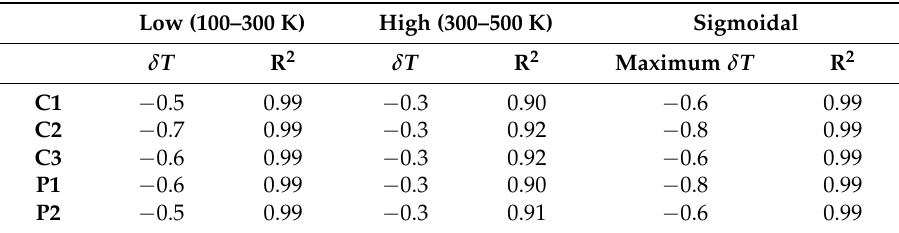
Figure 5. Temperature sensitivity of each sample based on a sigmoidal fit and a as a constant value based on a linear fit in regions above and below the reference condition. Table 2. Temperature sensitivities, δT , and corresponding R 2 values.